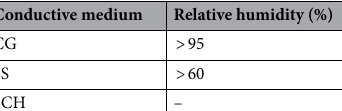
Table 7. Applicable humidity range of different conductive media for the two-point